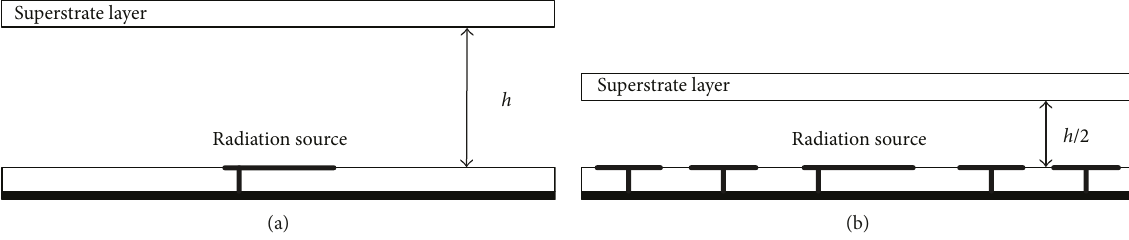
Figure 8: The schematic diagrams of the microstrip antenna with (a) the FSS superstrate and (b) the FSS and